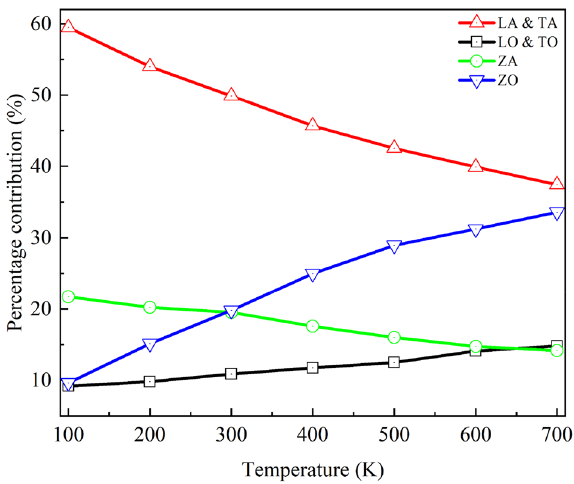
Figure 6. The percentage contribution of various phonon modes as a function of